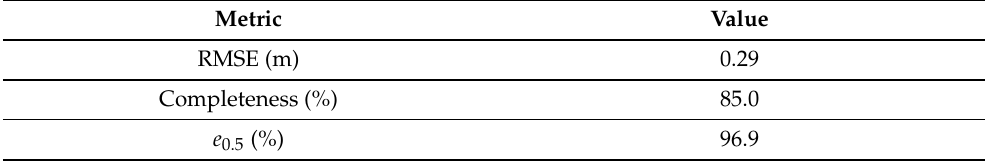
Table 3. Validation of the obtained results from the comparison with the ISPRS benchmark